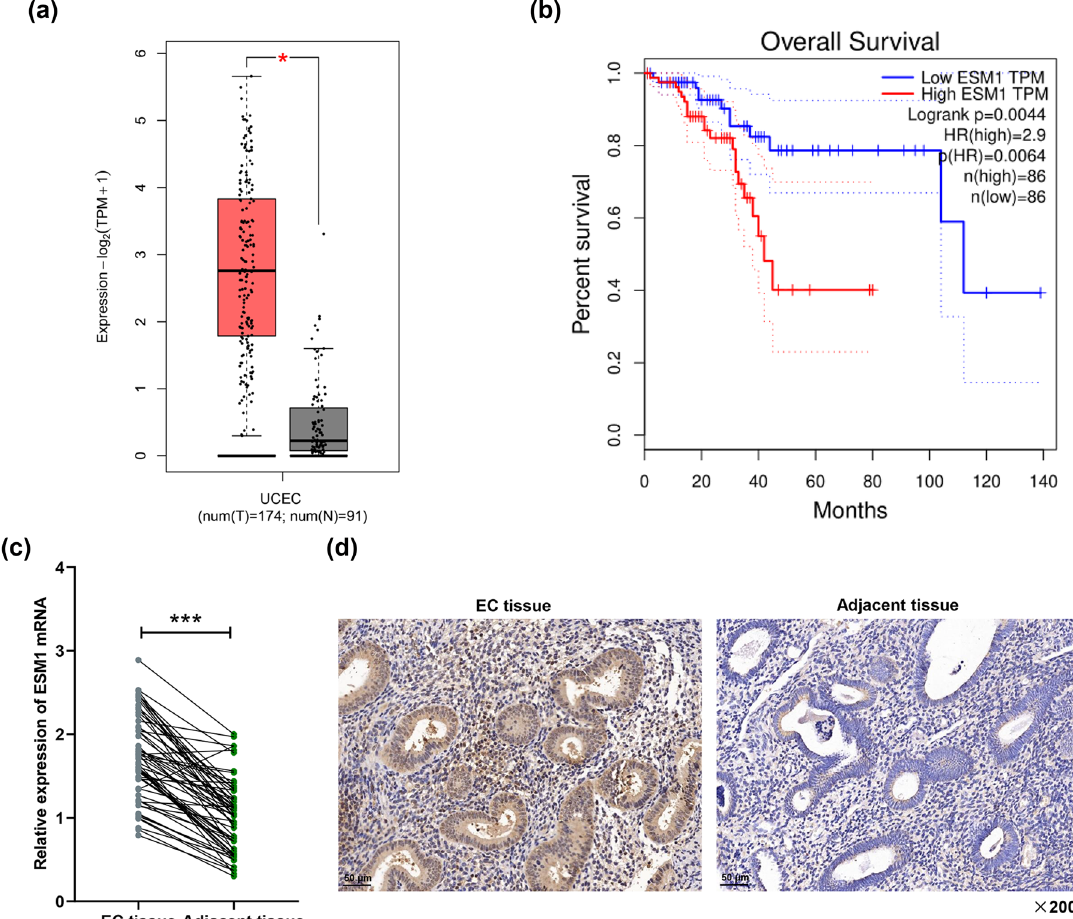
Figure 1: ESM1, which was highly expressed in EC, and patients with high expression of ESM1 had a poor prognosis. ( a ) The expression of ESM1 in UCEC was analyzed, and ESM1 was highly expressed in EC. ( b ) High ESM1 expression was signi fi cantly associated with the poor prognosis of EC patients. ( c ) The cancer tissues and adjacent tissues of 64 EC patients were collected to determine the expression of ESM1 by qRT - PCR. ( d ) The expression of ESM1 in the cancer tissues and adjacent tissues of EC patients was detected by immunohistochemical staining ( magni fi cation: × 200 times ) . GAPDH was used as a standardized gene. The experimental data are represented as mean ± standard deviation. *** P < 0.001 vs adjacent